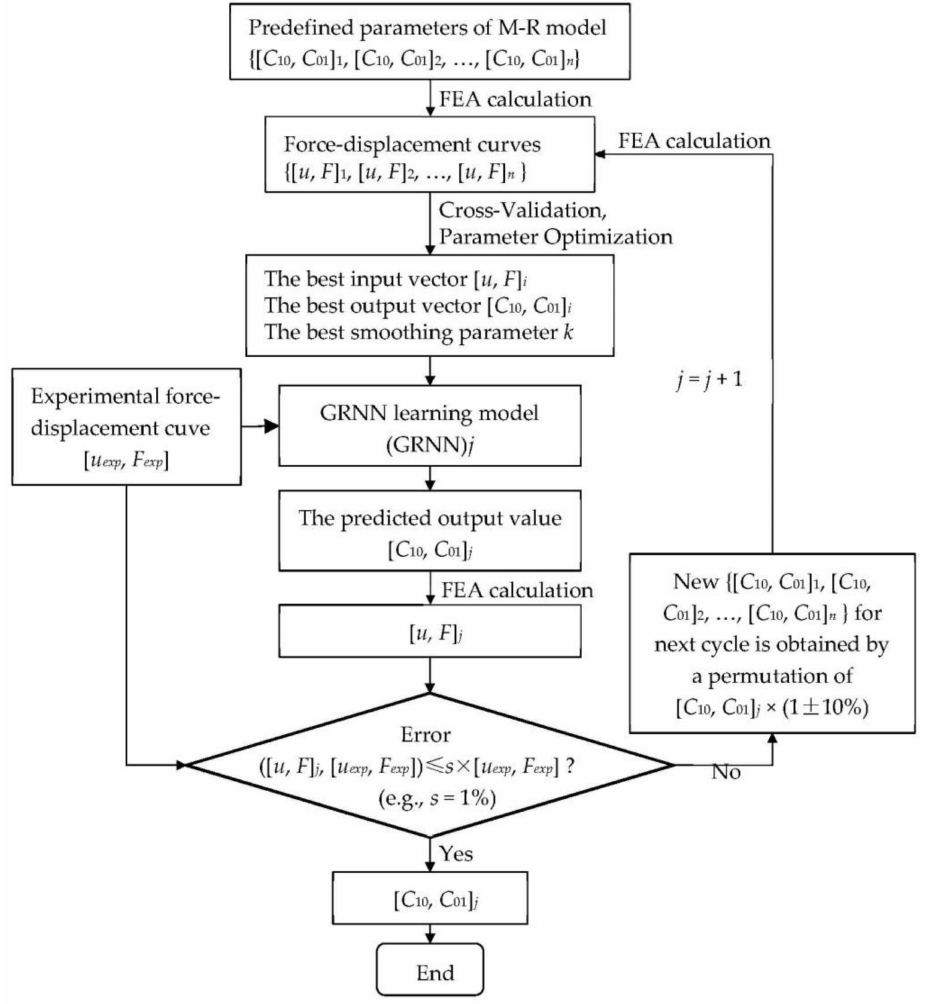
Figure 1. The scheme of the topological structure of a GRNN-based approach for the prediction of model parameters of M–R model. Nomenclature: u displacement; F reaction force; n number of learning samples; exp experimental results; j the cycle number of the GRNN model; s the given accuracy